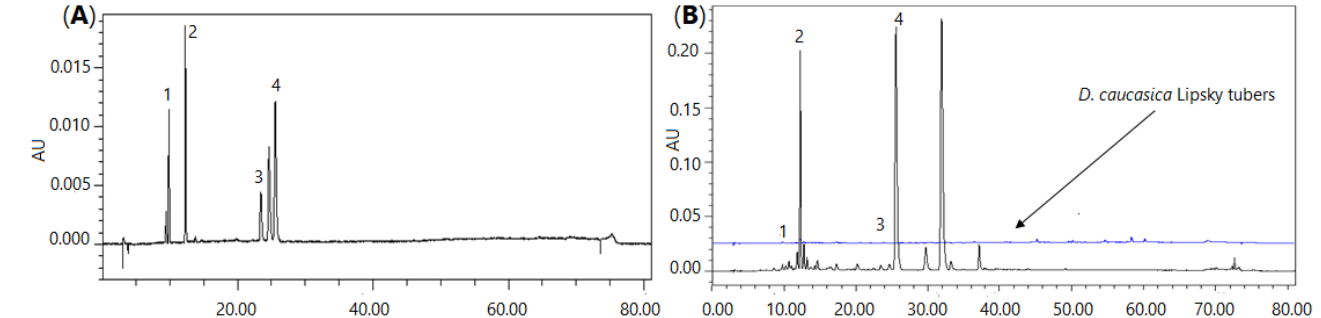
Figure 1. Chromatographic profile of D. caucasica leaf and tuber extracts ( B ) and the mixture of reference phenolic compounds ( A ): 1—neochlorogenic acid, 2—chlorogenic acid, 3—rutin, 4—isoquer- citrin.